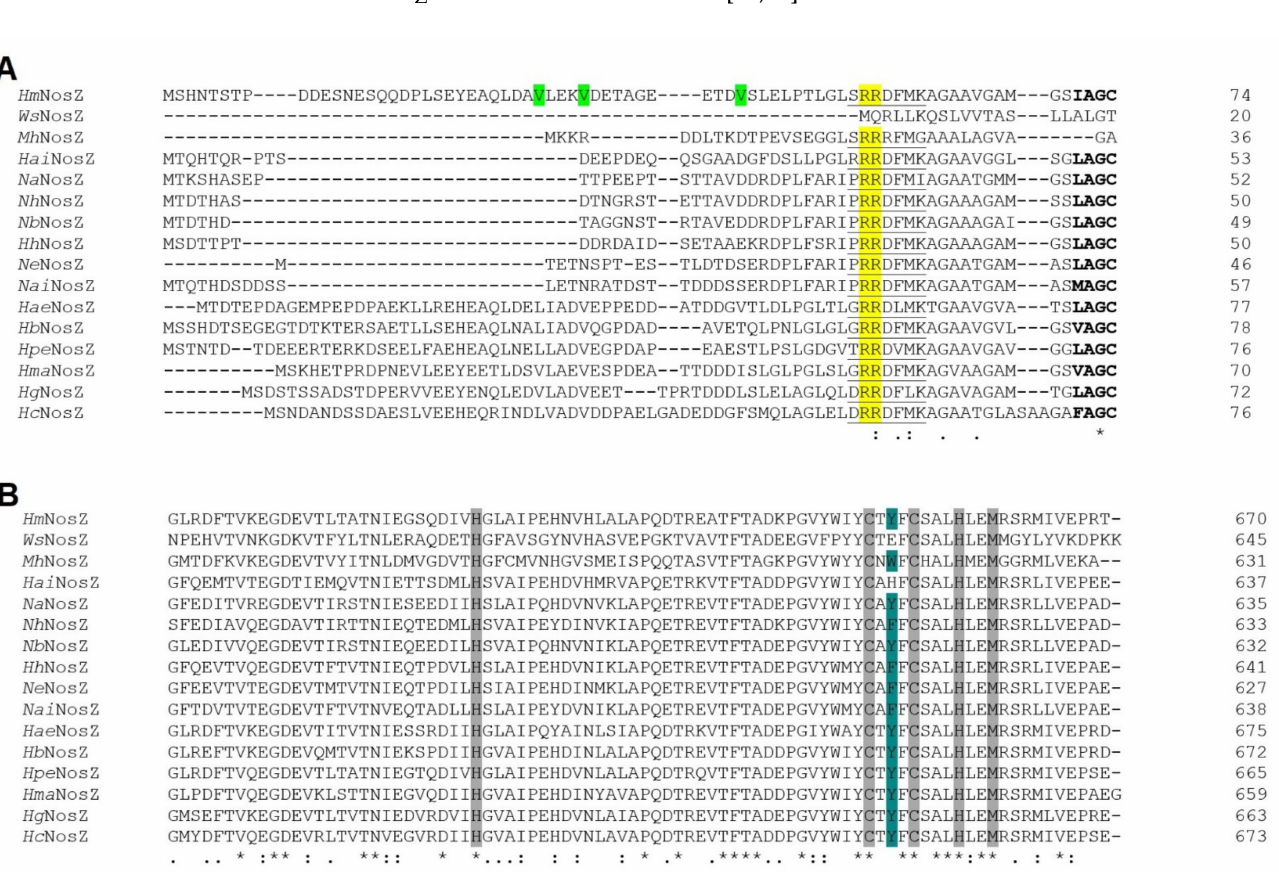
gion. The TAT consensus sequence [ST]RRxFLK is underlined, and lipoprotein consensus sequence is in bold. Twin arginine ‘RR’ and hypothetical start codons of Haloferax mediterranei NosZ are highlighted in yellow and green, respectively. ( B ) Cu A centre coordination. Conserved residues coordinating Cu A centre atoms are highlighted in grey whereas conservative substitutions are highlighted in